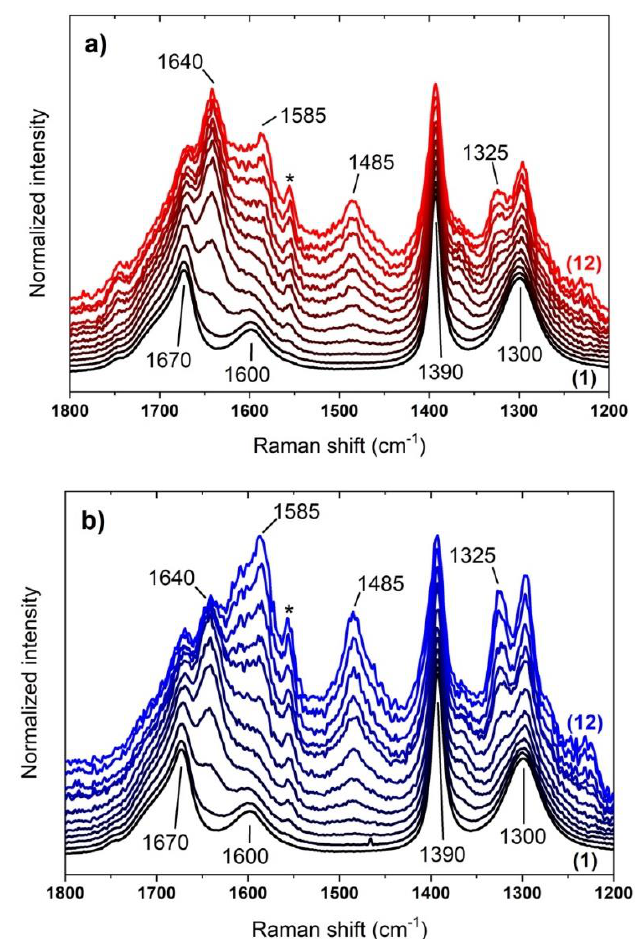
Figure 2. UV-Raman ( λ = 266 nm) spectra collected in situ during 12 h of reaction of formamide at 160 ◦ C on amorphous SiO 2 (Aerosil OX50): ( a ) as such; and ( b ) calcined at 450 ◦ C. A spectrum per hour was collected (time evolution from (1) black to (12) red / blue), in order to obtain a su ffi cient signal-to-noise ratio. Spectra have been normalized to the intense feature of formamide at 1390 cm − 1 and vertically shifted for the sake of visualization. The asterisk (*) marks the feature associated to atmospheric O 2 , as present in the optical path of the instrument.